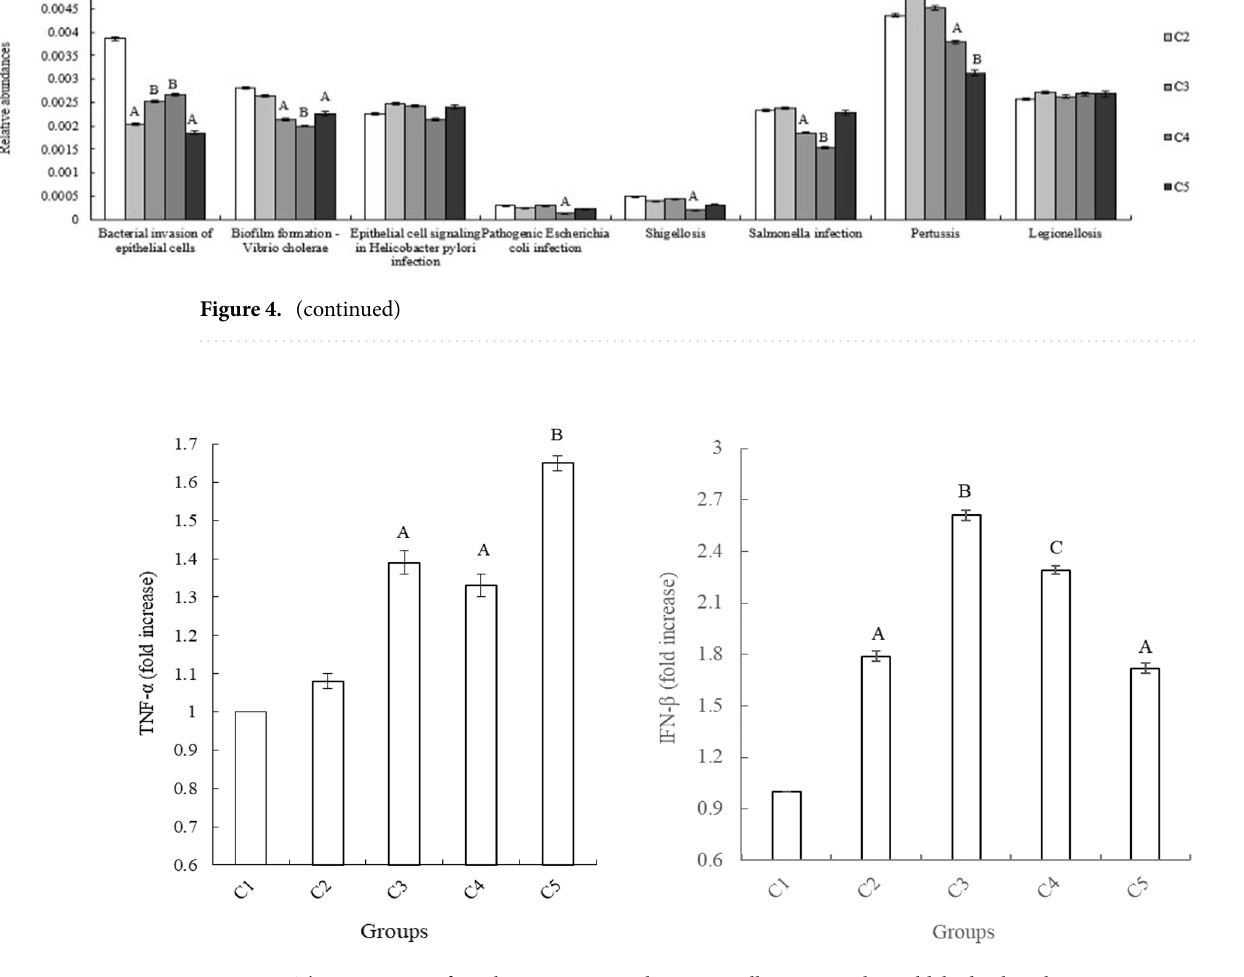
Figure 5. The expression of cytokines in intestinal mucous cells. mRNA: glyceraldehyde phosphate dehydrogenase (GAPDH) internal control was used for statistical comparison. Values represented by vertical bars are means with standard errors. Significant differences from the control group were determined by one-way ANOVA followed by Duncan’s multiple comparison tests: superscript capital letters in the same color of column and in the same experimental duration mean P < 0.01. The Microsoft Office Excel 2010 was used to as the stamp